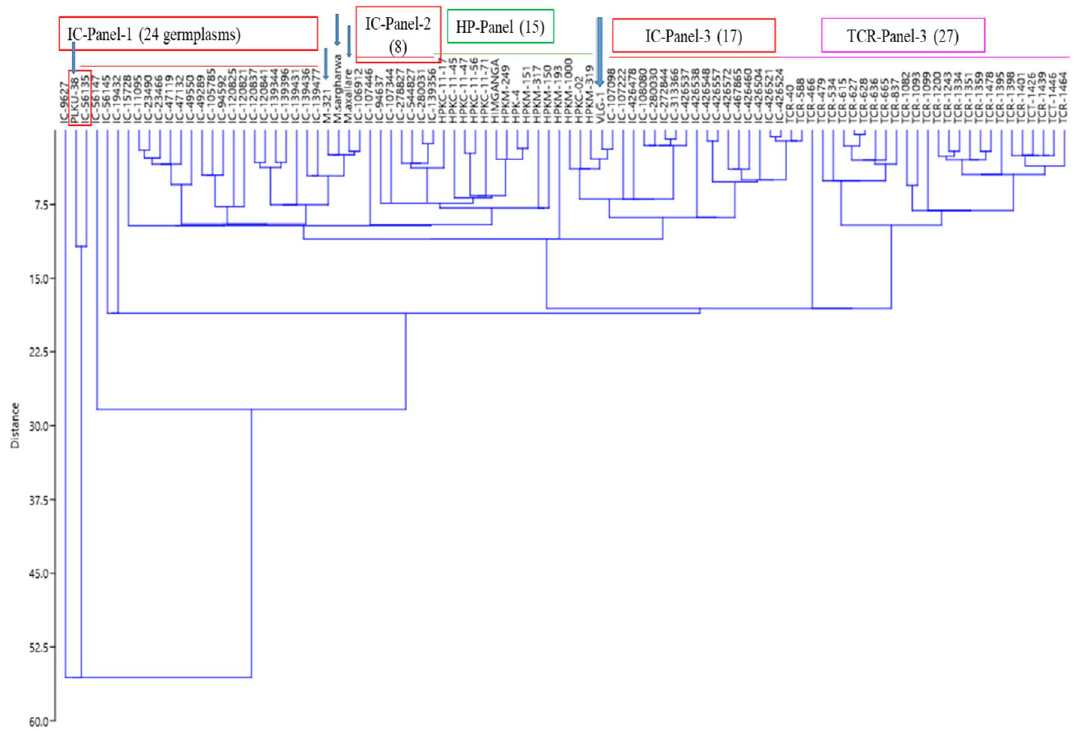
Figure 5. Hierarchical clustering among horsegram germplasm on the basis of 1 H NMR data for the targeted